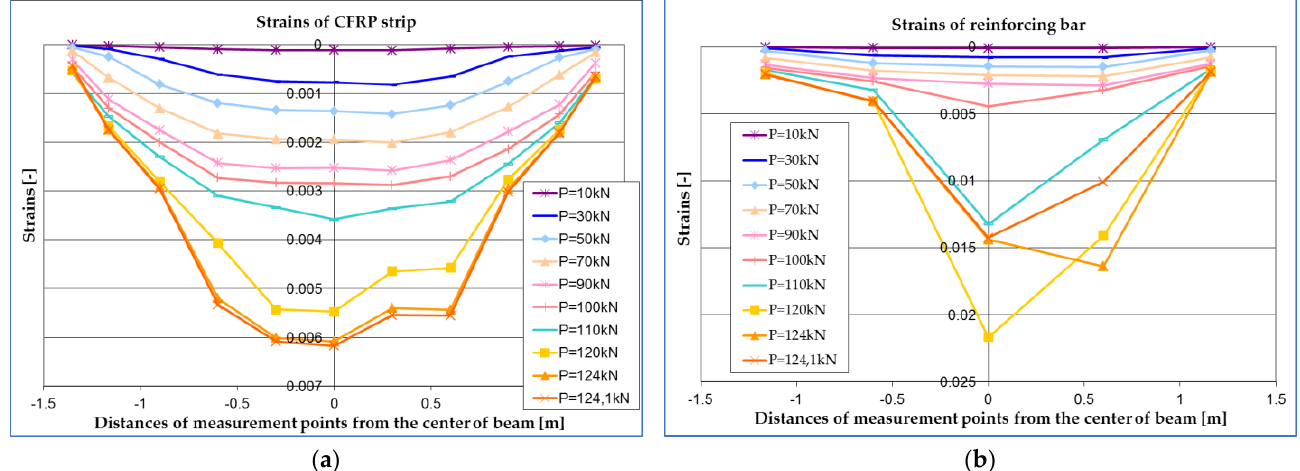
Figure 9. Strains in Bz-1 beam: ( a ) of composite strip and ( b ) of middle reinforcing bar.